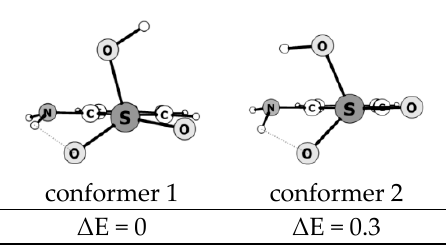
Figure 5. The structure of the 2-NH 2 -BSAconformers and their relative energies ( Δ E, kJ mol − 1 ).